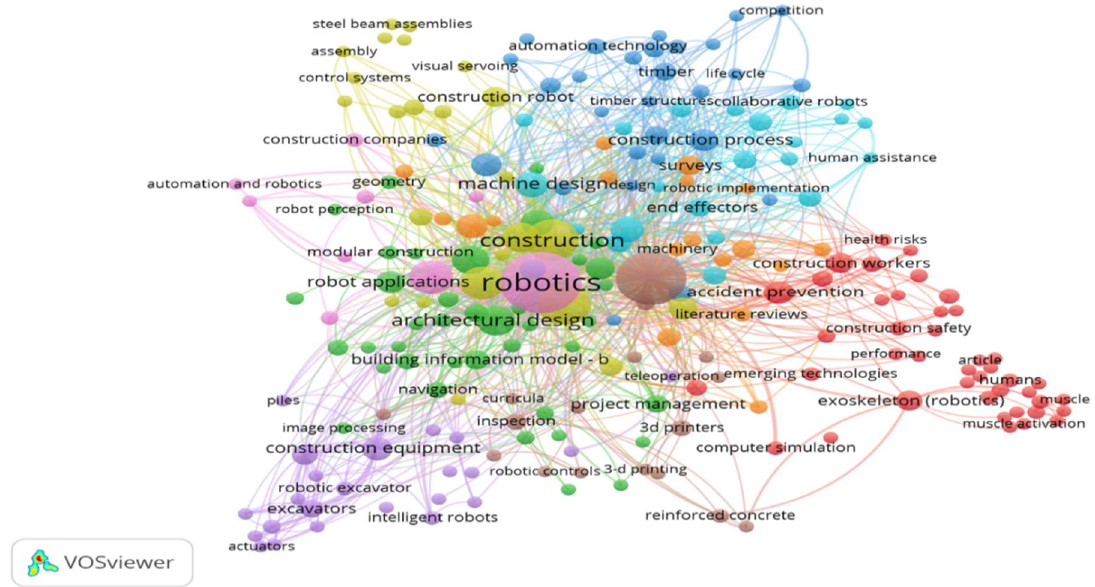
Figure 4. Co-occurring